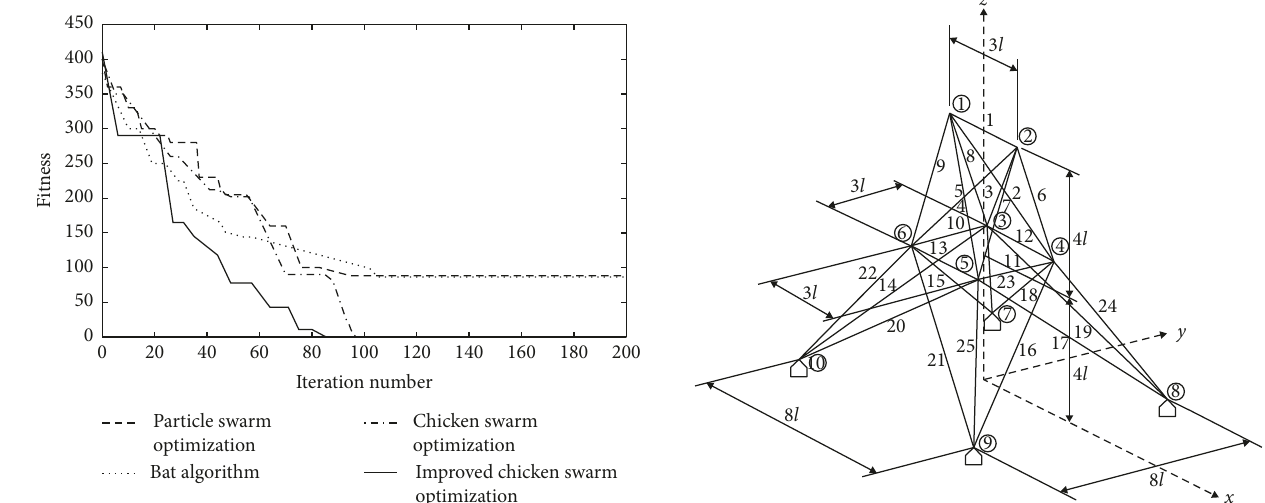
( x ) with 30 dimensions. 2